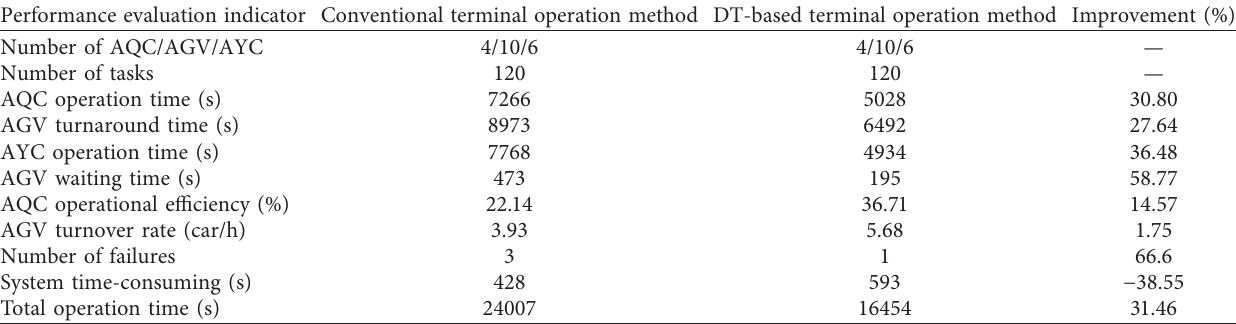
Table 4: Test results of conventional and DT-based operations for large-scale